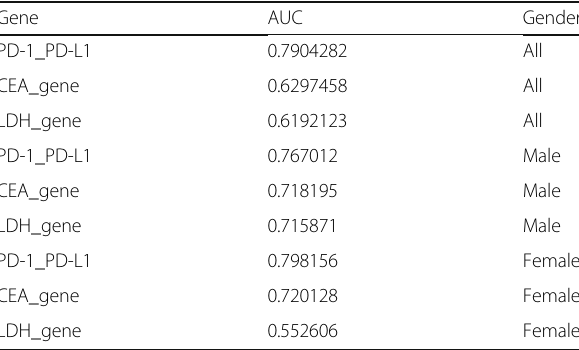
Table 5 The classification efficiency of PD-1, PD-L1, CEA- encoding and LDH-encoding genes for both or single gender